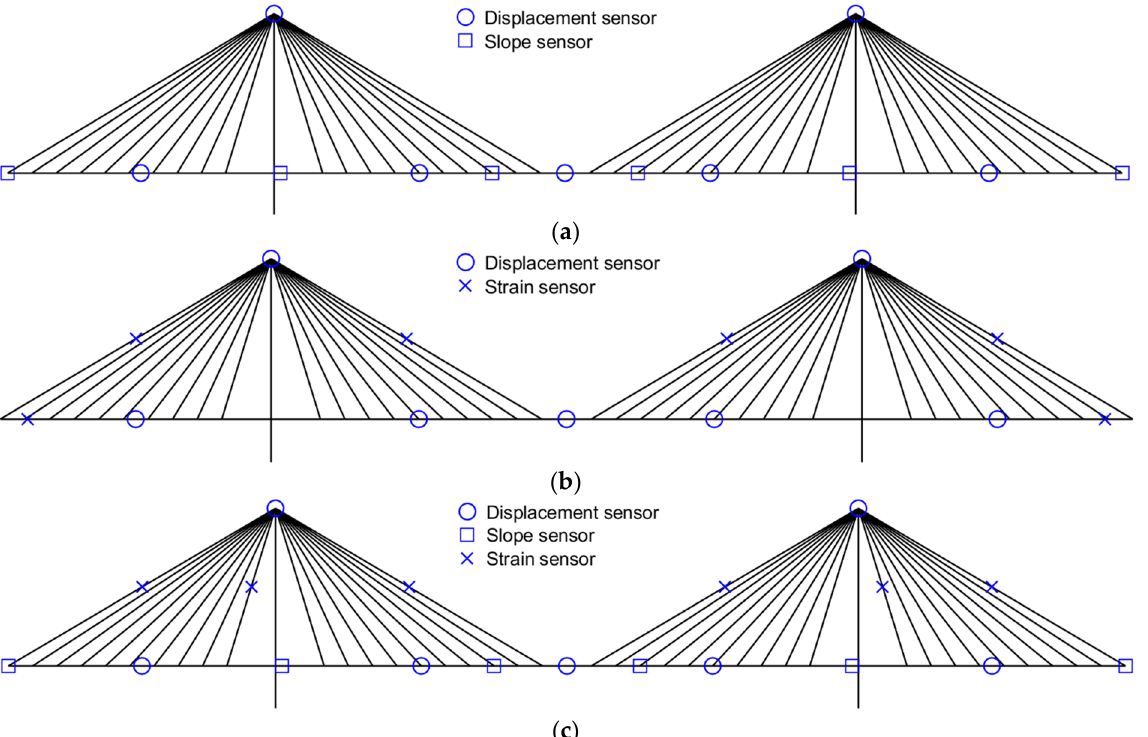
Figure 6. Example of measurement location using 7 displacement sensors. ( a ) ω = 7, ø = 6, ε = 0; ( b ) ω = 7, ø = 0, ε = 6; ( c ) ω = 7, ø = 6, ε = 6.